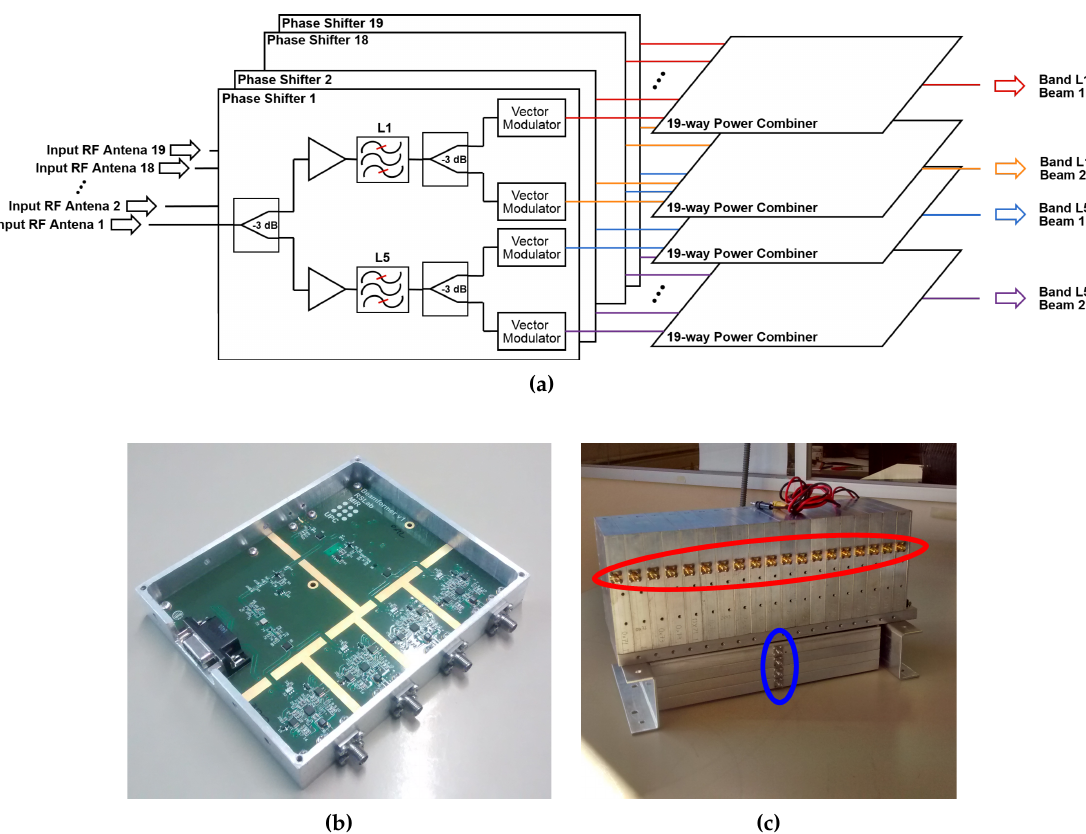
Figure 6. Block diagram of one of the beamformers ( a ), close view of one of the phase shifters manufactured ( b ), and front picture of one of the assembled beamformers ( c ). Note in the assembled beamformer 19 inputs (red), and the 4 outputs (blue).